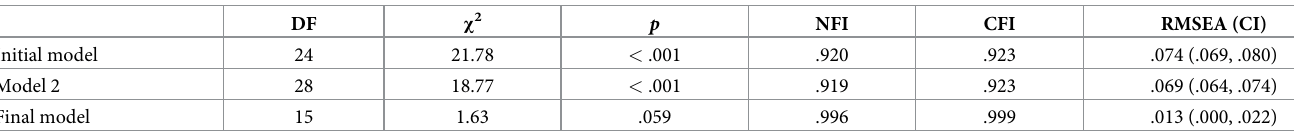
Table 5. Model fit